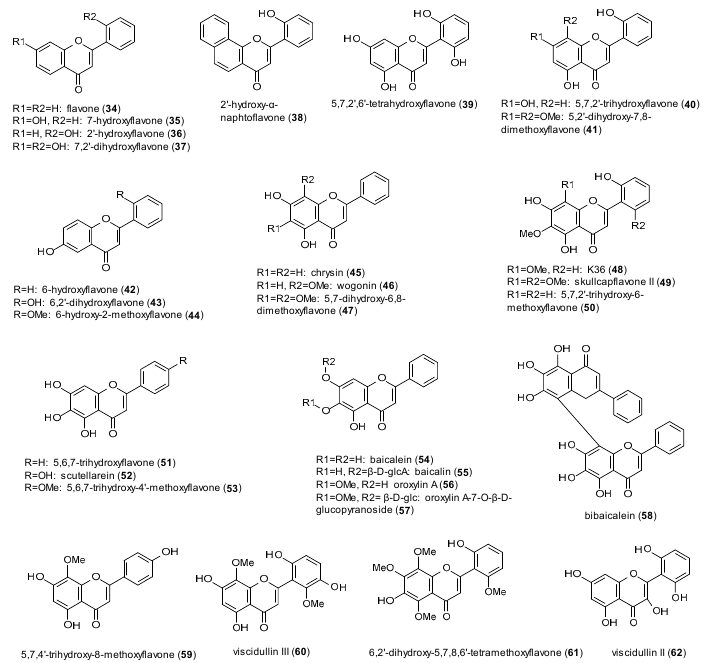
Figure 3. Chemical structures of flavones from Scutellaria baicalensis with reported GABA(A)-receptor modulating activity.